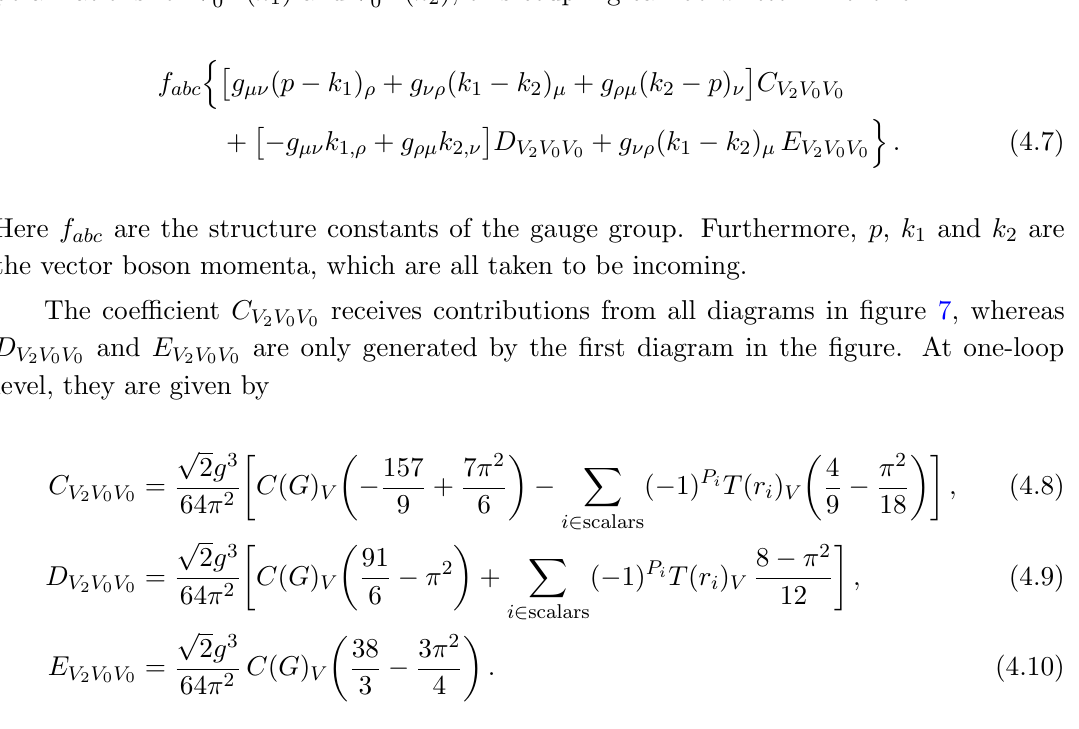
and ~ D are independent of ln((cid:3) R ), 2 0 V 0 2 0 V 0